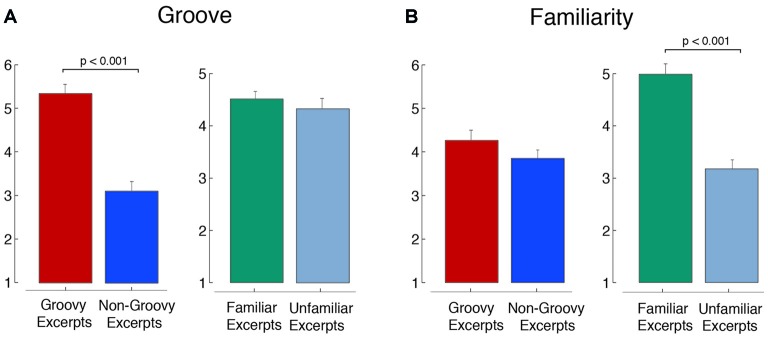
Groove and familiarity in the selected excerpts. The figure shows the ratings of (A) groove and (B) familiarity for the music excerpts (means ± standard error).